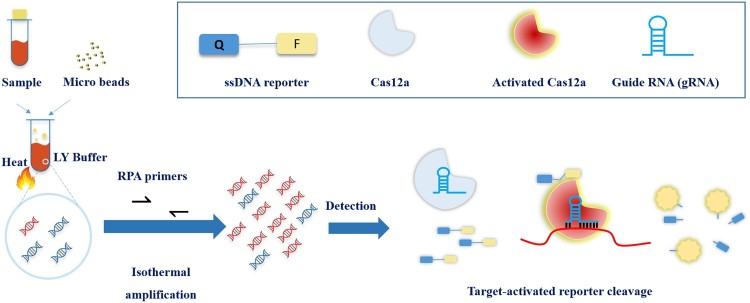
Scheme of CRISPR-MTB. Samples were added into LY buffer with microbeads, and were vortexed/heated. Supernatants were subjected to CRISPR-MTB system. Positive fluorescent signals were captured when probes were cleaved by activated Cas12a under target sequence recognized by gRNA.